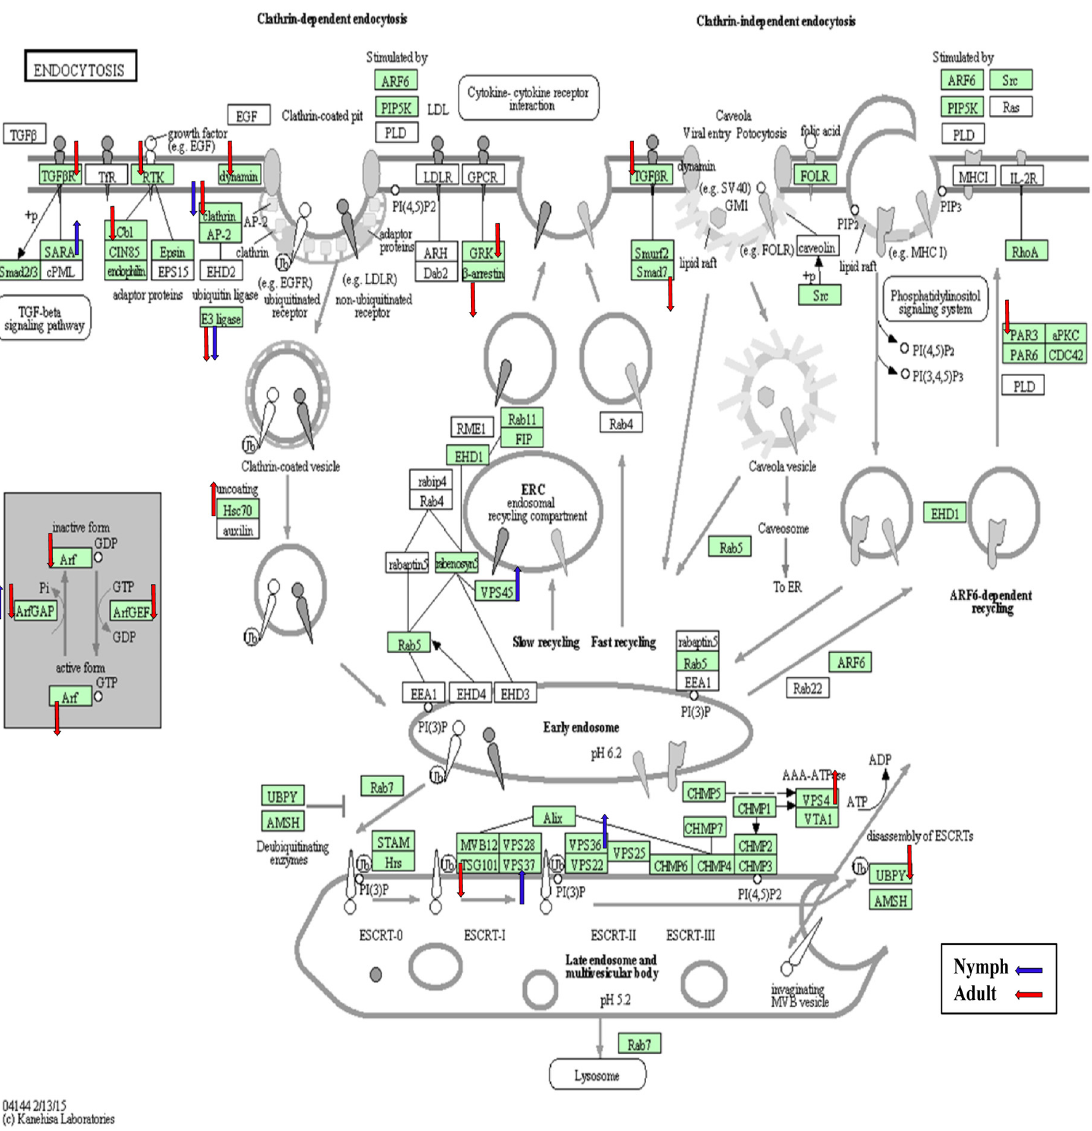
Fig 3. The Endocytosis KEGG pathway diagram showing the contigs that were differentially expressed ( p < 0.05) in nymphs (blue arrows) and adults (red arrows) in response to CLas infection. Of the assigned contigs (shaded in green), 22 were differentially expressed either in the nymphs or